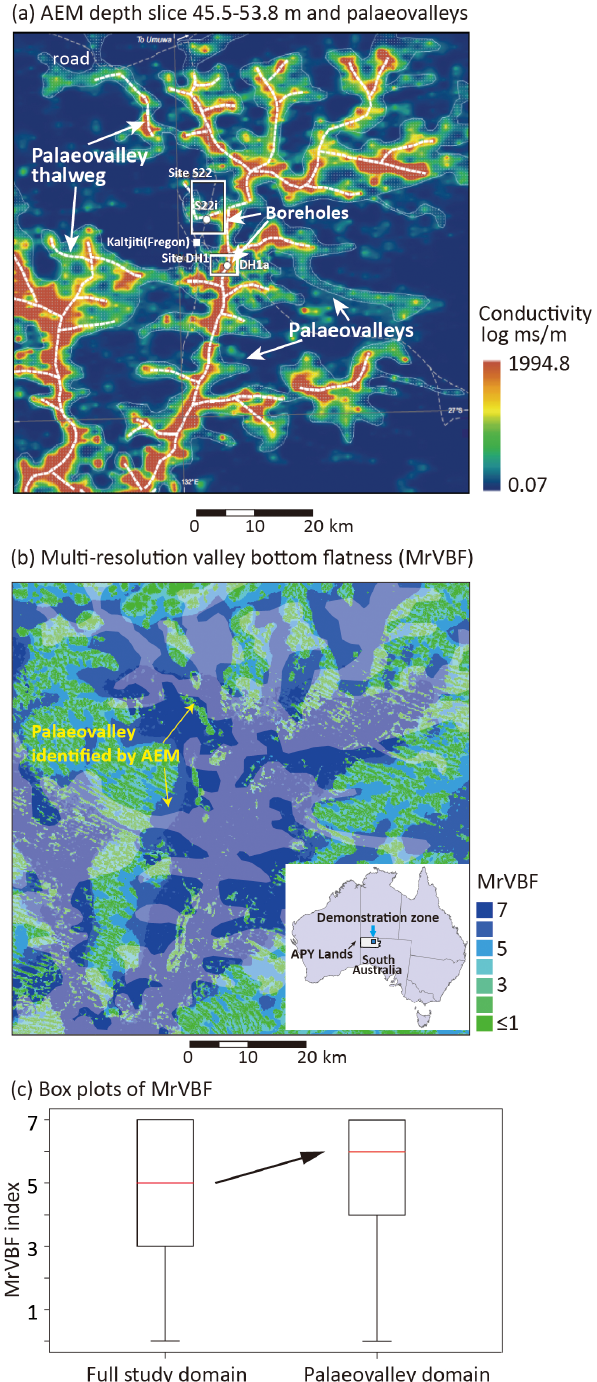
Figure 4. (a) Airborne electromagnetic (AEM) depth slice showing conductive paleovalley areas, (b) corresponding MrVBF map with paleovalley overlay, and (c) boxplot (interquartile range, median, and minimum value) of MrVBF across full study domain and for paleovalley domain